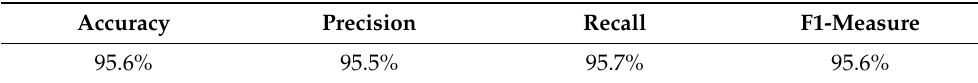
Figure 9. The metrics’ results for the three best networks obtained after 20 AutoKeras trails. Table 2. Evaluation metrics’